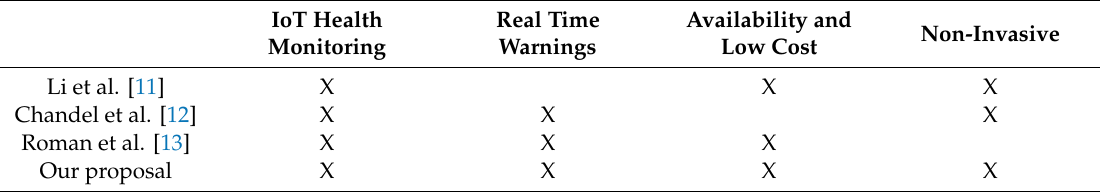
Table 1. Advantages of related